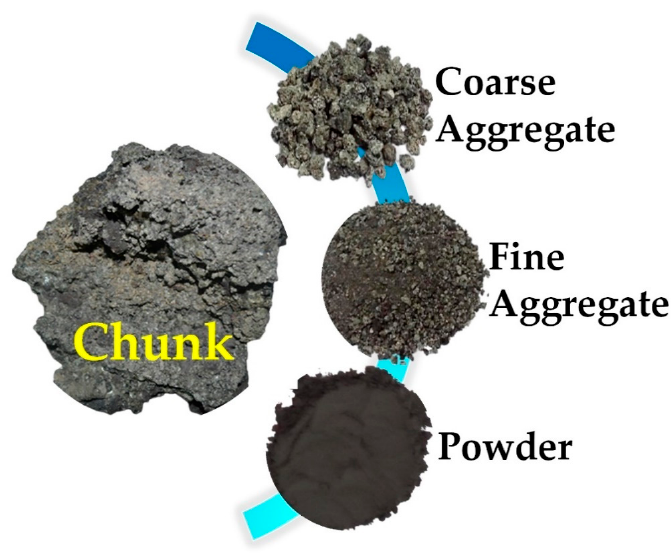
Figure 3. POC chunk, coarse aggregate, fine aggregate, and powder [28] . Table 2. Chemical composition of POC.